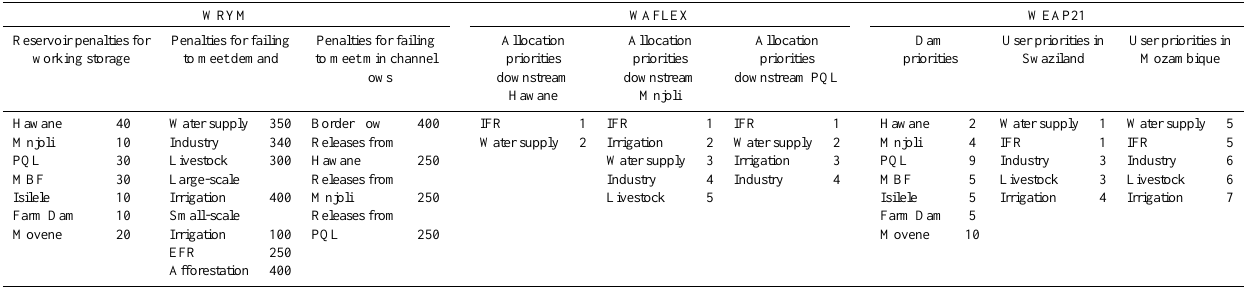
Table 5. Configuration used for the three system models applied for the Umbeluzi River basin. PQL=Pequenos Libombos, IFR=Instream Flow Requirements, EFR=Estuarine Flow